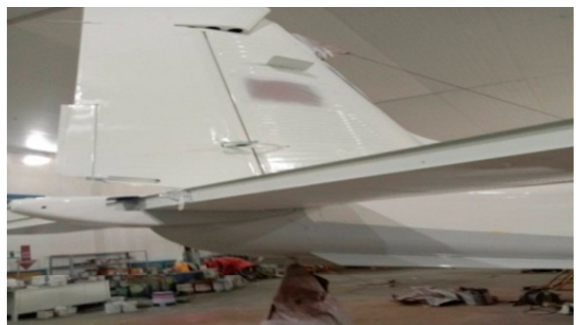
Figure 6. RTN painting’s